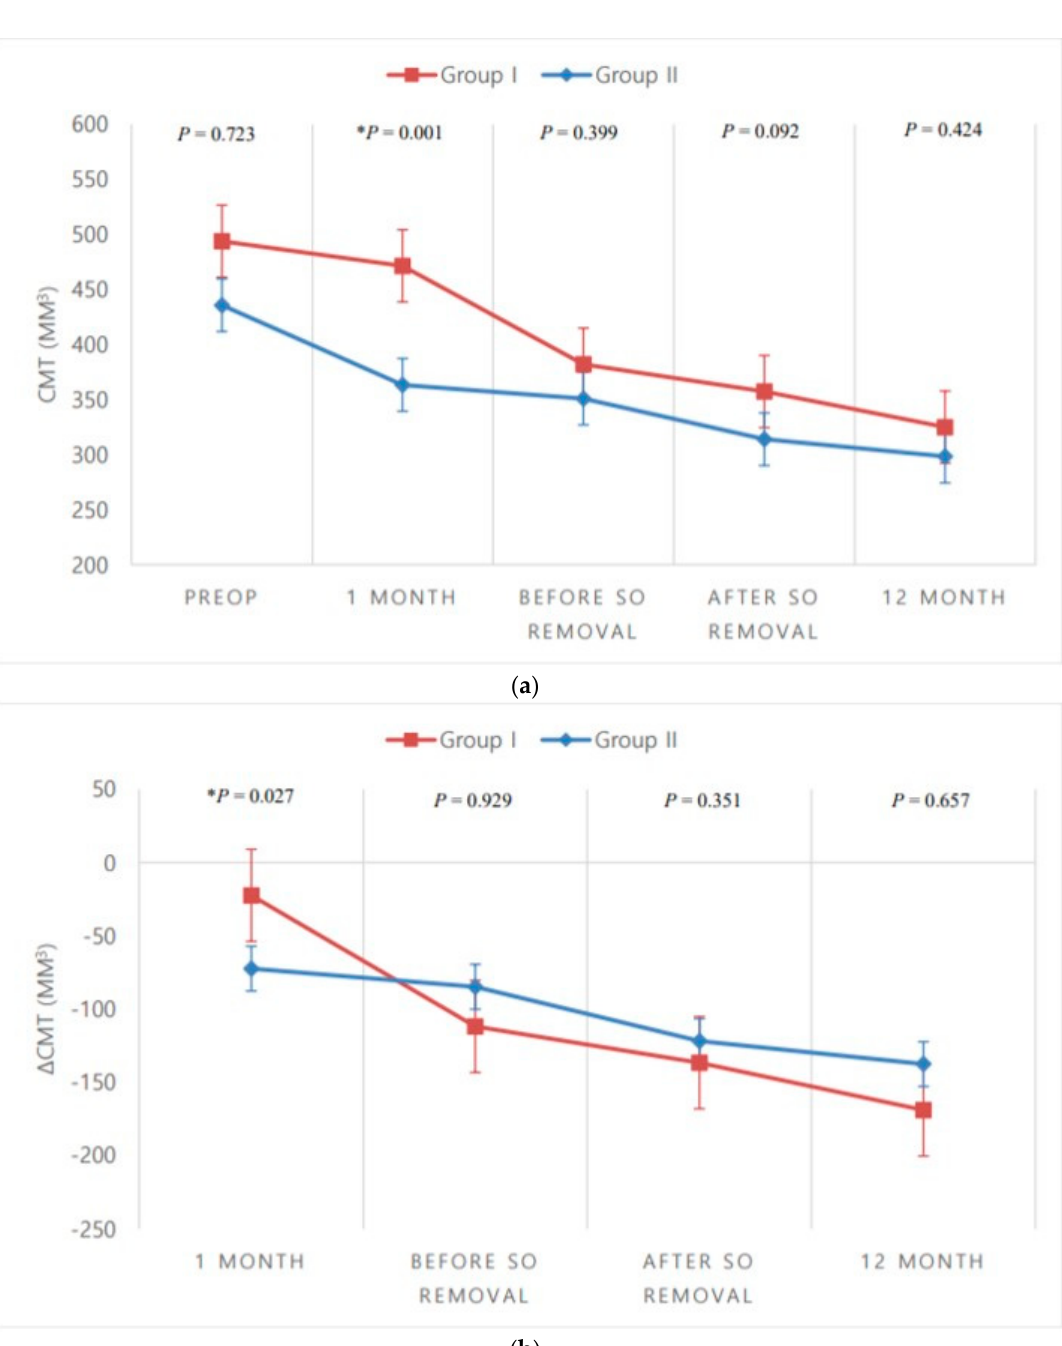
Table 3. Postoperative Complications and Other Outcomes.